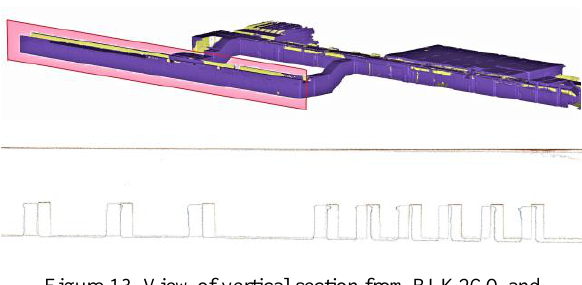
Figure 13. View of vertical section from BLK2GO and Matterport (with scale distortion) clouds